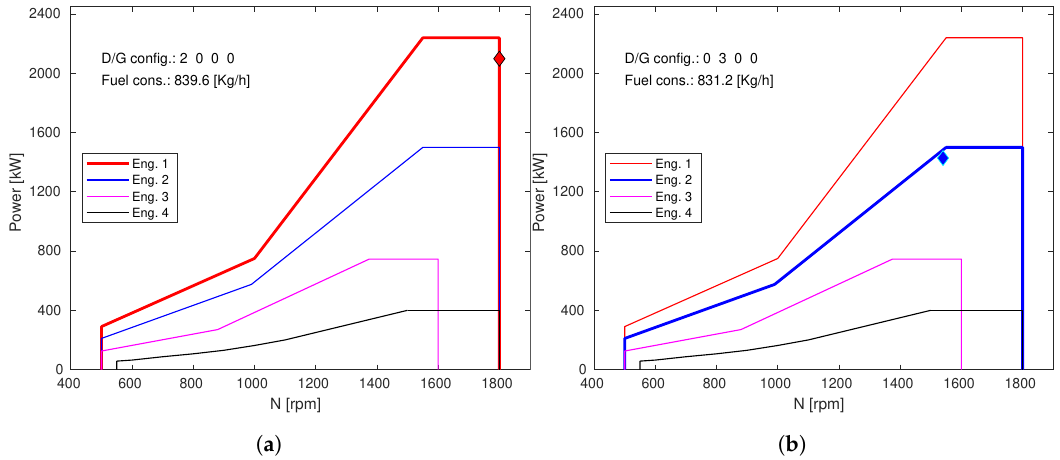
Figure 4. Solutions: constant speed D/G ( a ) and variable speed D/G ( b